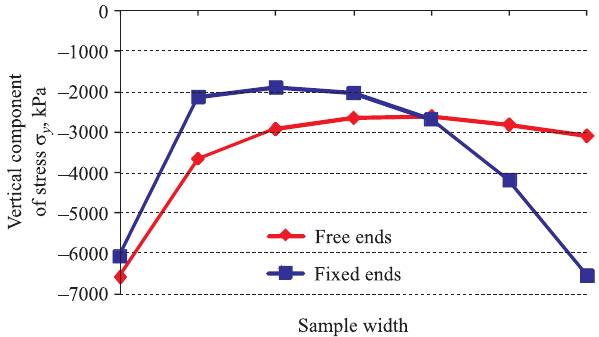
Fig. 13. Distribution of vertical stress component s y of specimen base along the section of sample (along X